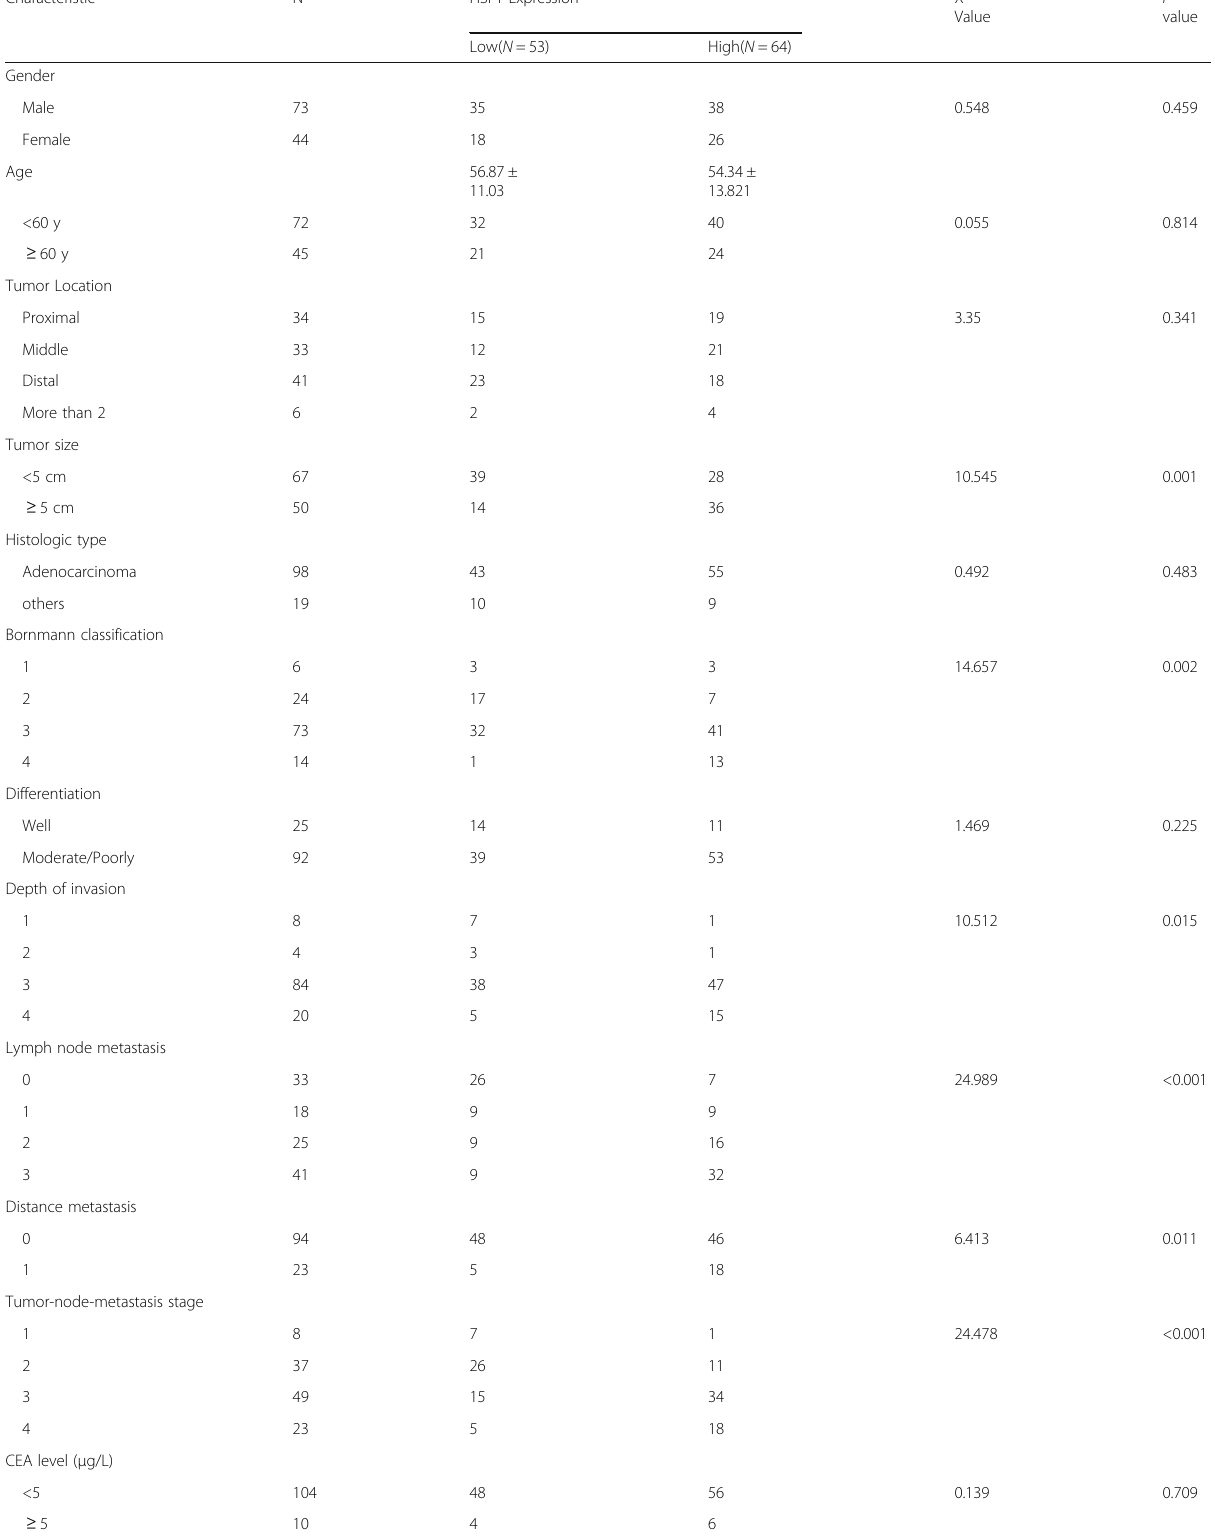
Table 1 Correlations between HSF1 expression and the clinicopathologic variables of 117 GC